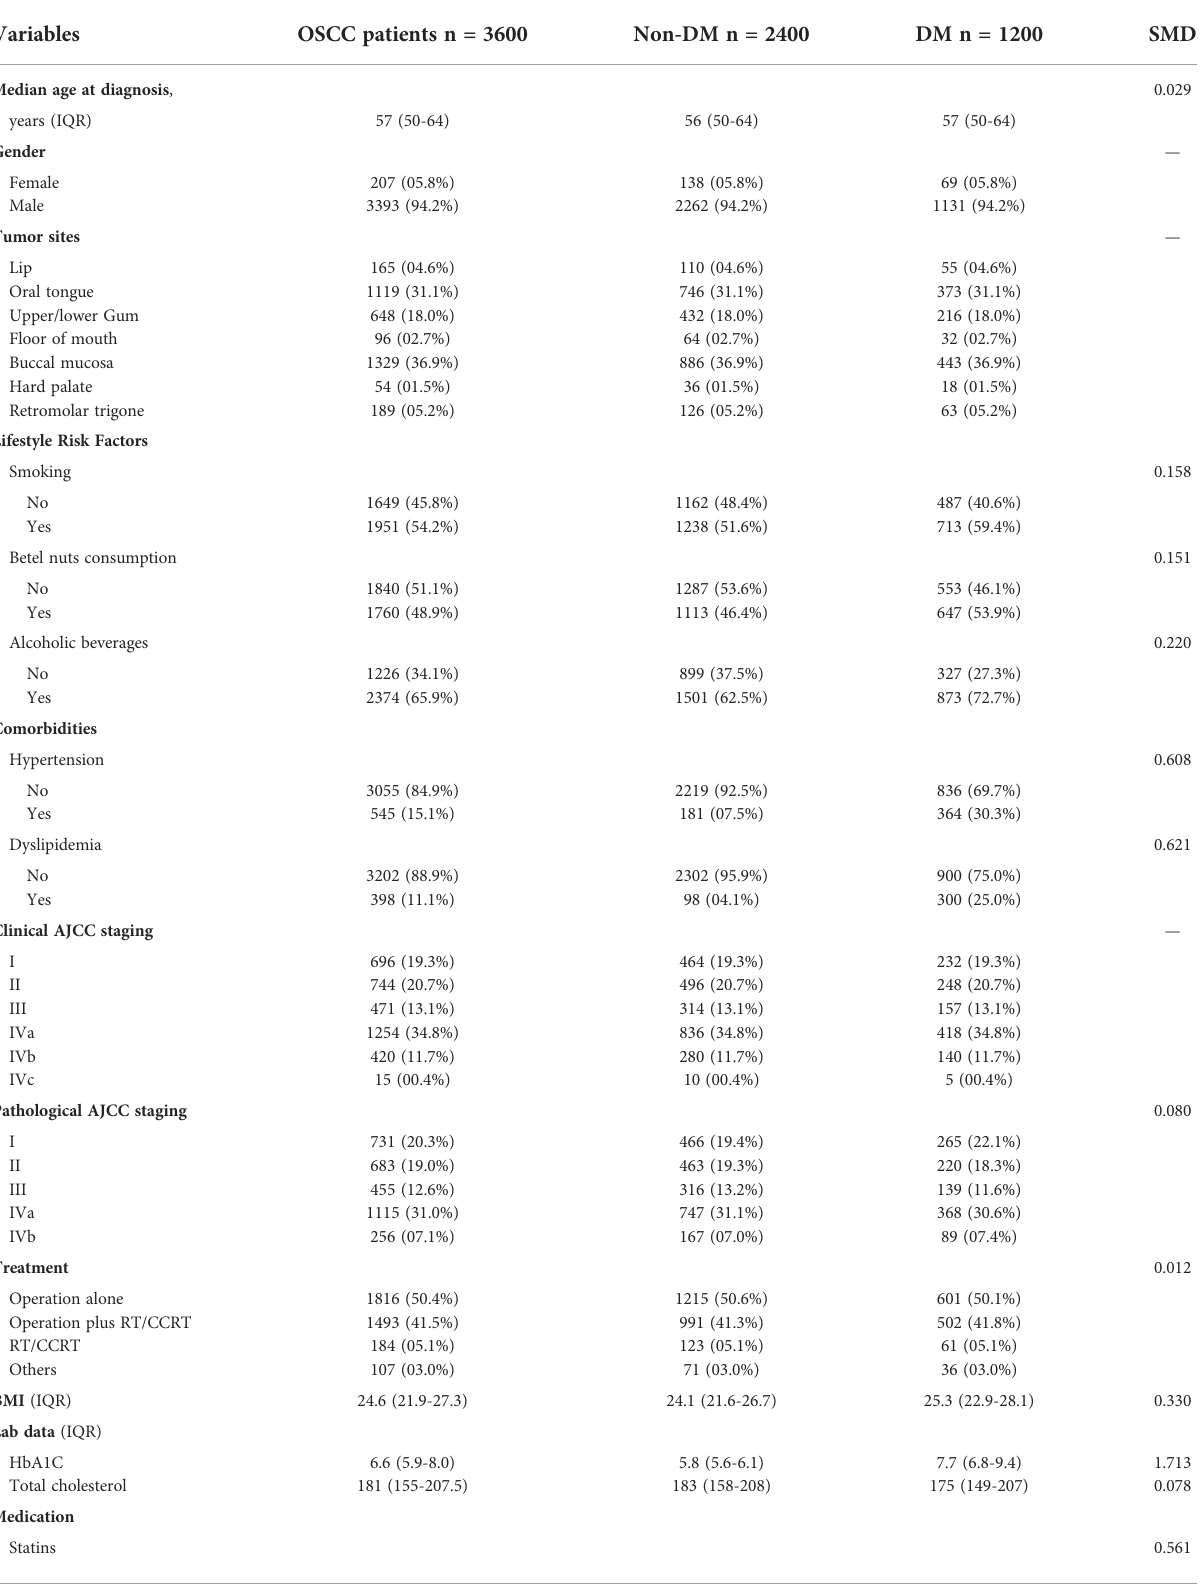
TABLE 1 Demographic and clinical characteristics of OSCC patients after frequency